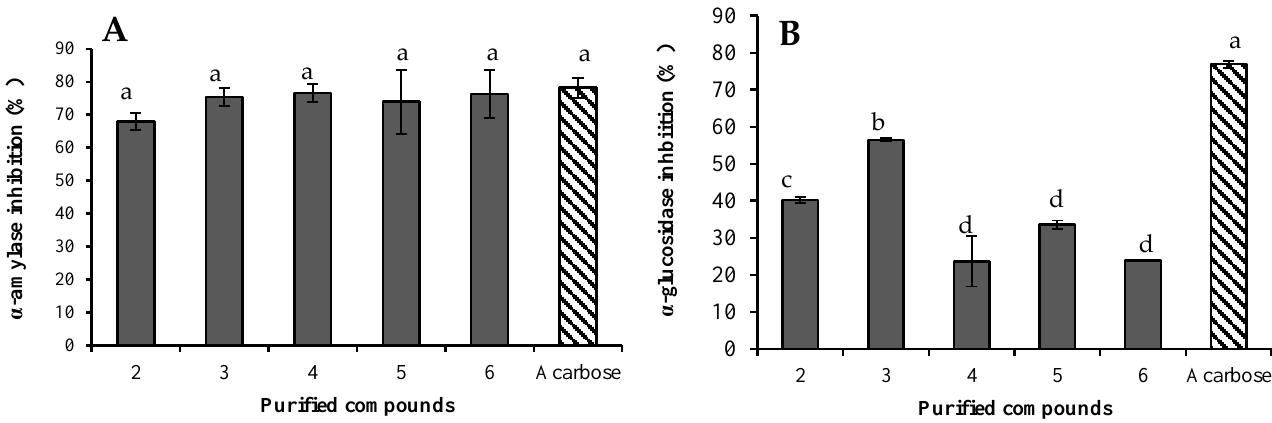
Figure 4. α -Amylase ( A ) and α -glucosidase ( B ) inhibitory effects of purified compounds: karaviloside VI ( 2 ), karaviloside VIII ( 3 ), momordicoside L ( 4 ), momordicoside A ( 5 ) and charantoside XV ( 6 ). Compounds were assayed at 0.67 mM and data are expressed as mean ± SD ( n = 3), and analyzed by one-way ANOVA with a Tukey post hoc test. Different letters within the same plot indicate there were significant differences at p < 0.05.